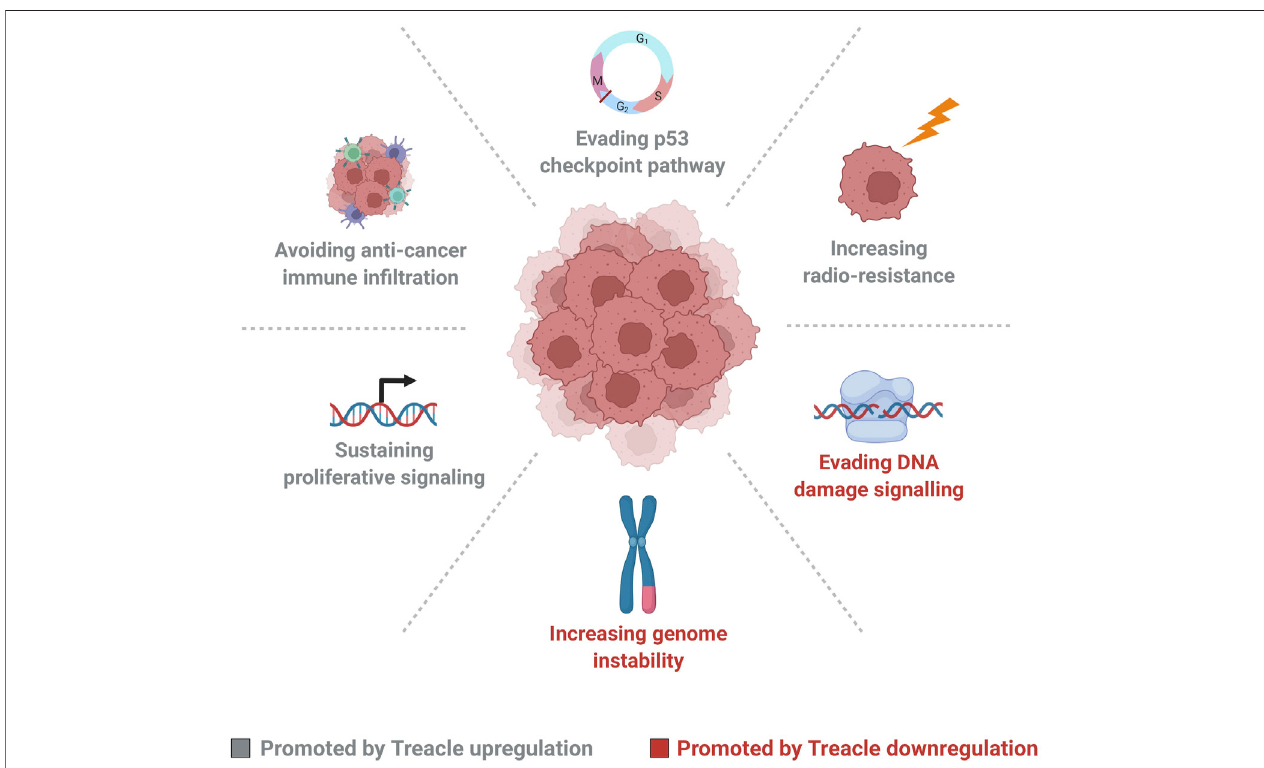
FIGURE 2 | Up or downregulation of Treacle expression levels contribute to cancer initiation and progression through promotion of various cancer hallmarks. Cancercellscanbene fi tfromTreacledownregulation,throughlossofthenucleolarDNA-damageresponse,promotinggenomeinstability,andevasionofDNA-damage signaling.Treacleupregulationmaybene fi tcancercellsthroughsustainedproliferativesignaling,evasionofp53checkpointactivation,avoidanceofanti-cancer immune in fi ltration, and through increasing radio-resistance. Cancer hallmarks promoted by Treacle upregulation are marked in grey and hallmarks promoted by Treacle downregulation are marked in red. Figure created with